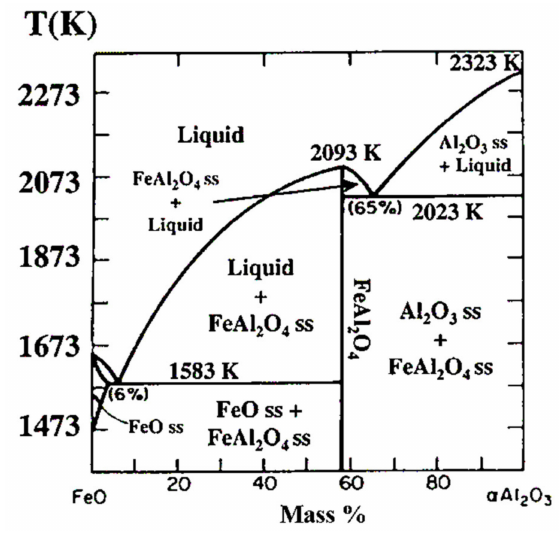
Figure 5. Phase diagram of FeO-Al2O3 system. Reproduced with permission from [24], Royal Society of Chemistry,